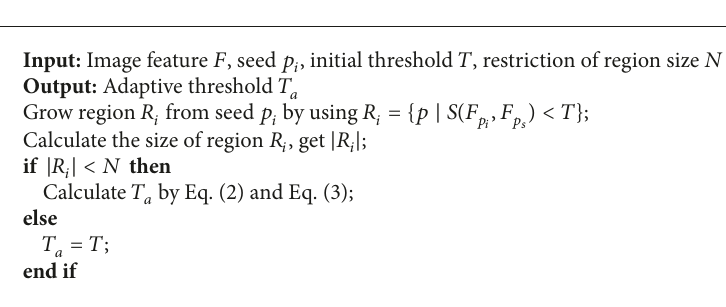
Algorithm 2: Adaptive threshold